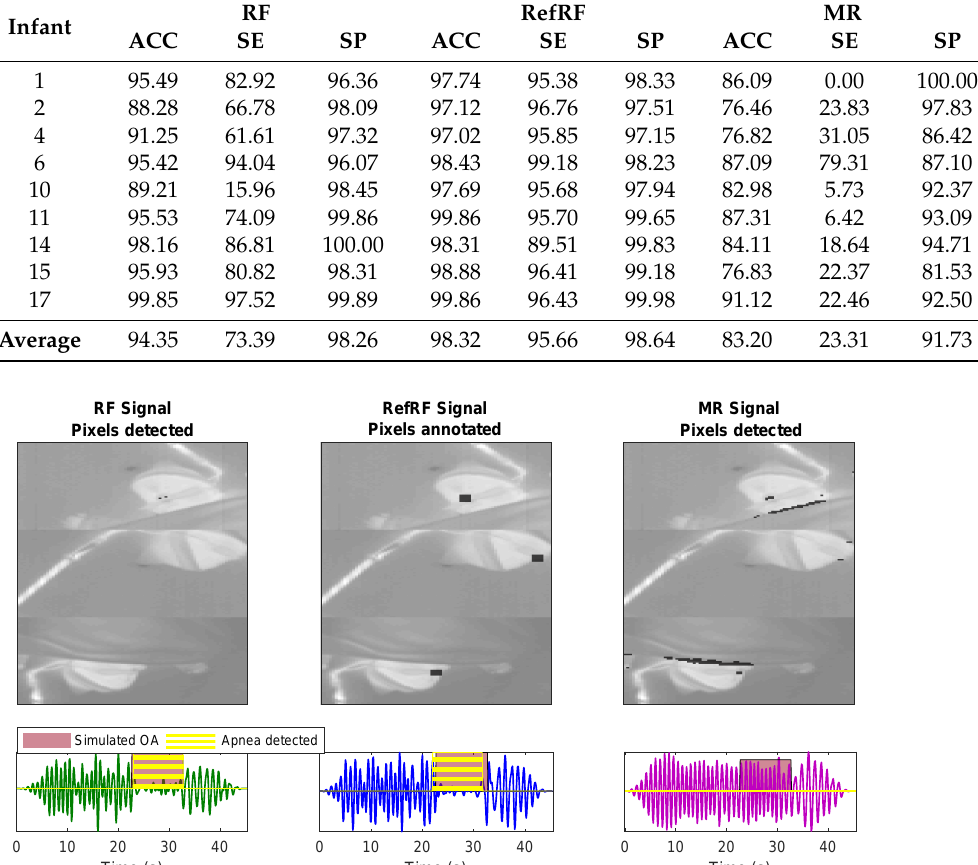
Figure 7. Example results of the automatic pixel detection step and of the OA simulation and detection step. The RefRF signal shows the simulated OA, the RF signal calculated using the automatically detected RF pixels is also able to detect the OA. In the MR signal , however, the OA is not visible, being the signal obtained by mixing RM and RF